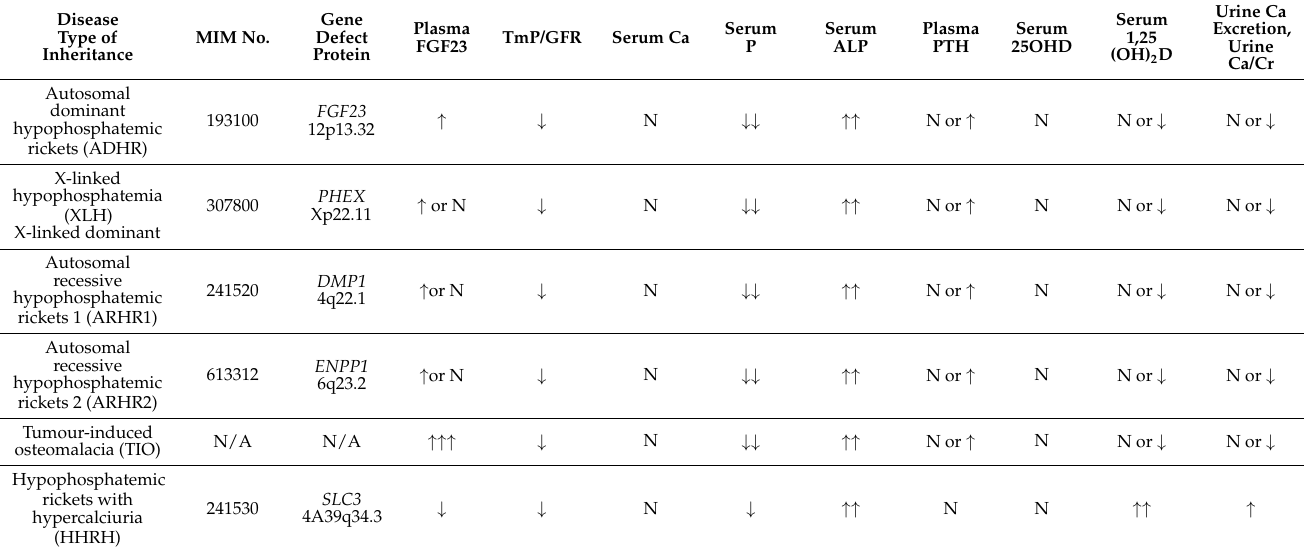
Table 5. Hypophosphatemic rickets genetic